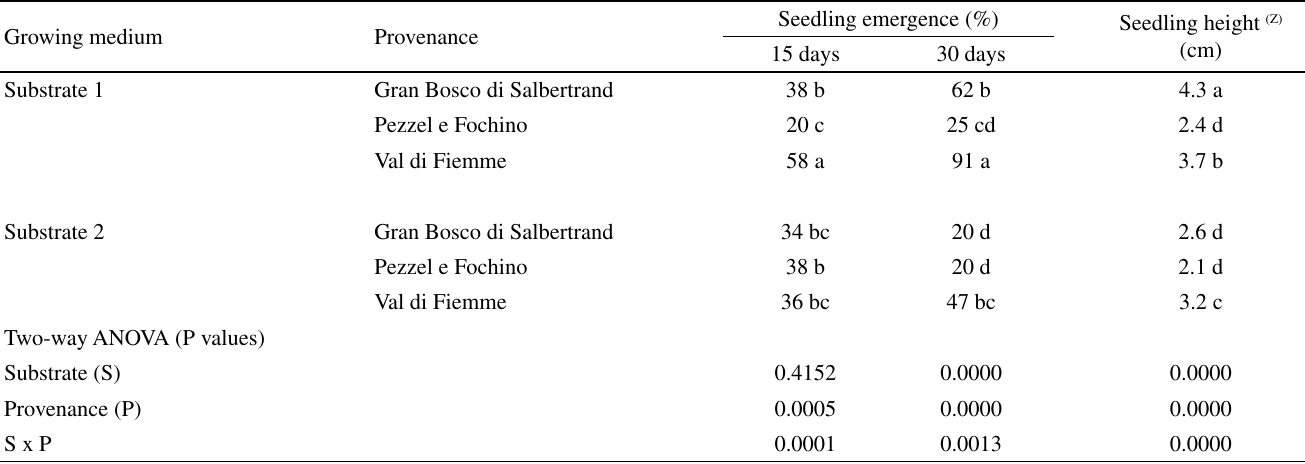
Table 3 - Seedling emergence and early growth of three provenances of P. abies in two different substrates Growing